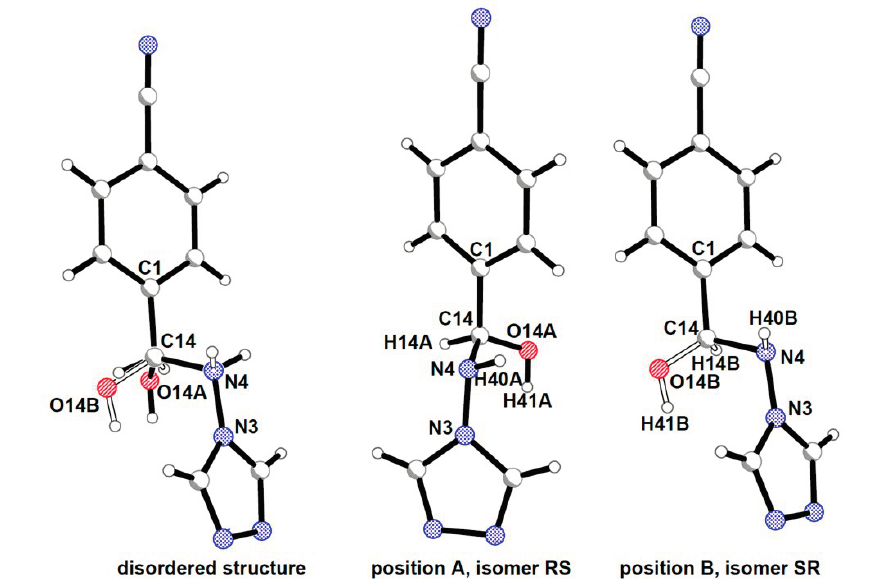
Figure 4. Model of the disorder in the crystal structure of 3 .